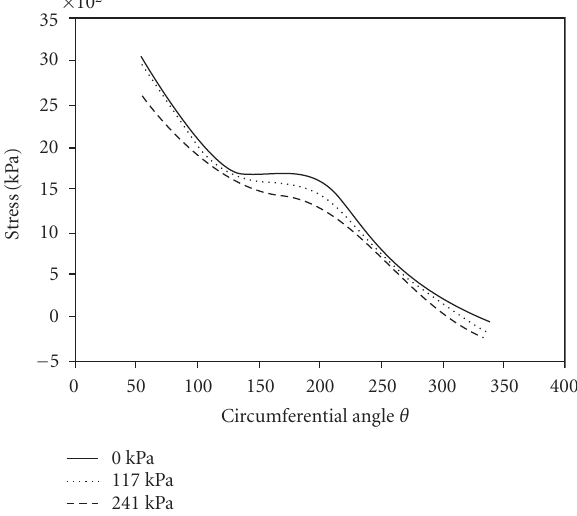
Figure 10: Influence of inflation pressure on the maximum princi- pal stress at the disk hat.